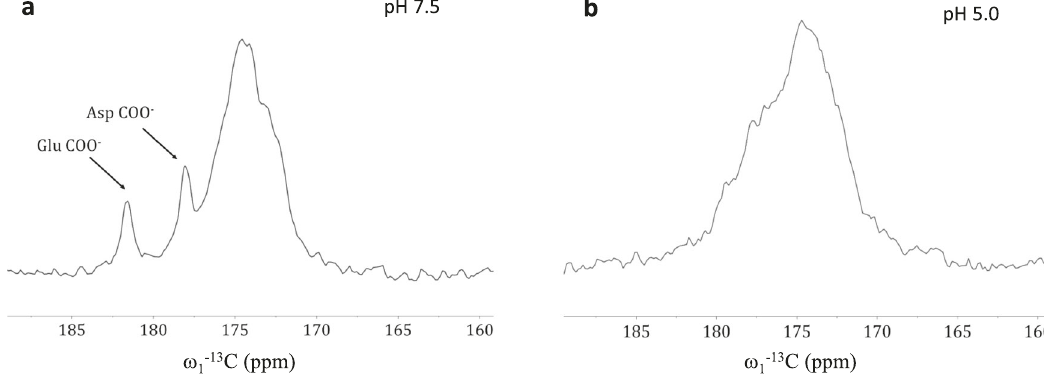
Fig. 2 NMR spectroscopy of PsbS. Glu and Asp protonation states at pH 7.5 and 5.0 probed by NMR spectroscopy. a 1D 13 C-DP MAS NMR spectra of PsbS at pH 7.5, b 1D 13 C-DP MAS NMR spectra of PsbS at pH 5.0. The spectra contain the sum of 1024 accumulated scans and a line broadening function of 50 Hz was applied for